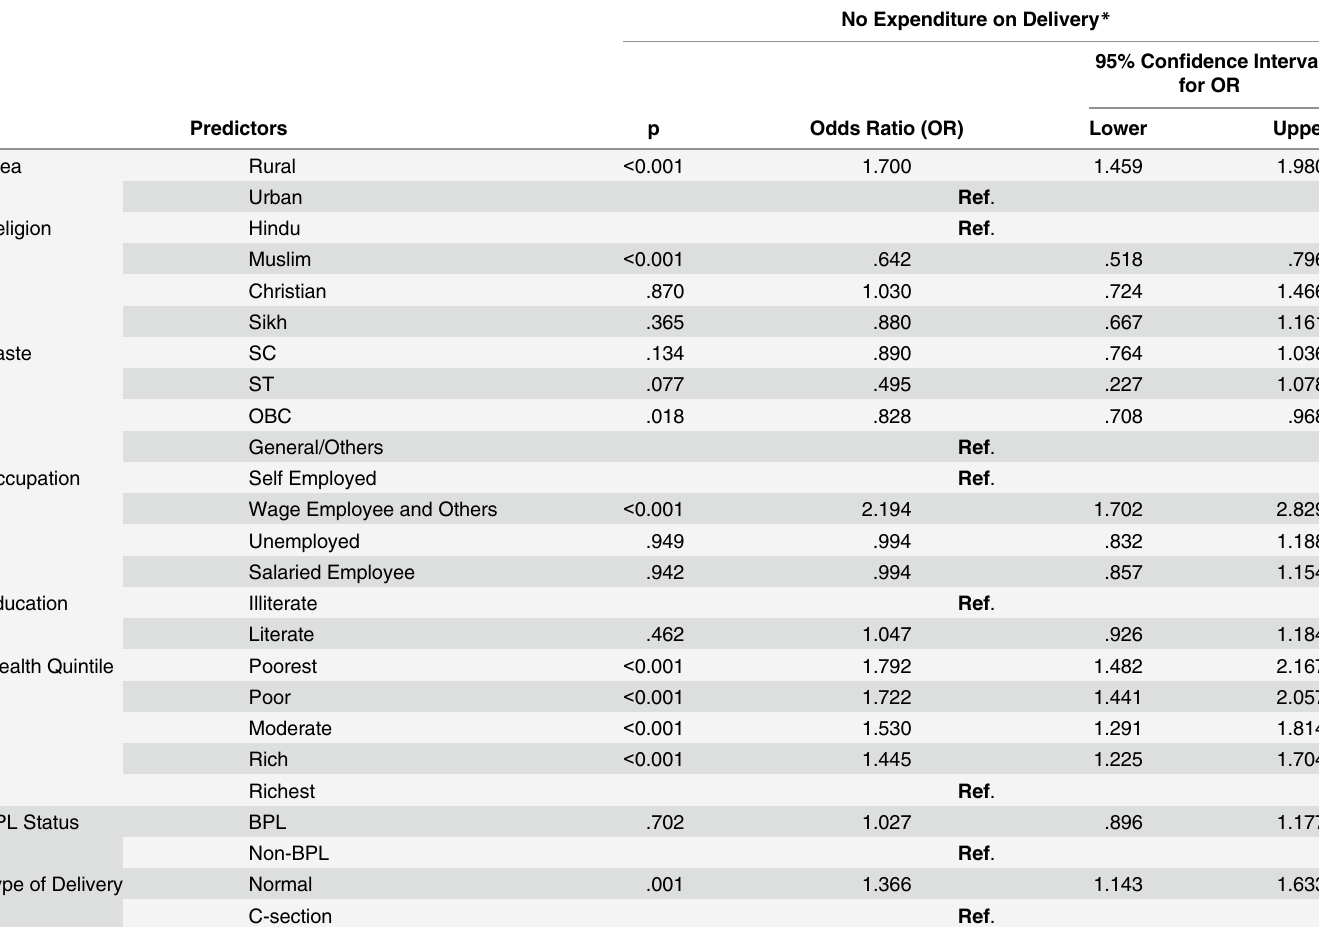
Table 4. Factors Affecting Financial Risk Protection for Delivery Using Logistic